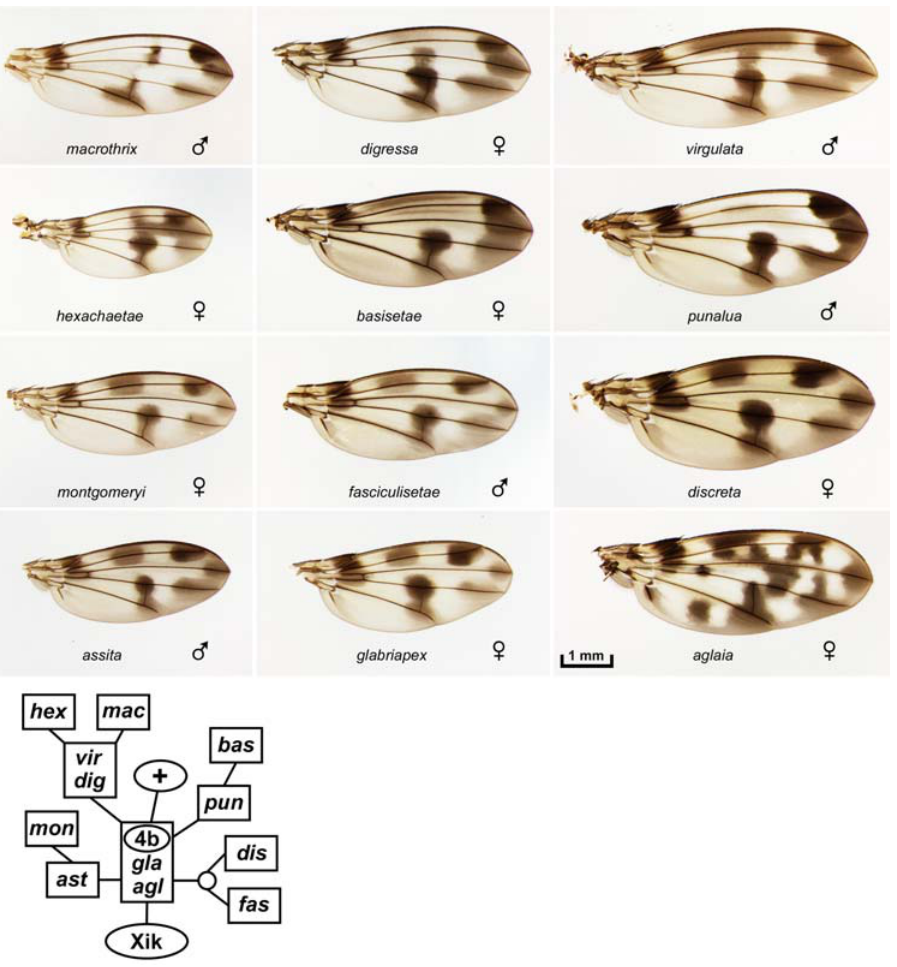
Figure 4. The glabriapex/4b subgroup of picture wing species: D. aglaia, assita, basisetae, digressa, fasciculisetae, glabriapex, hexachaetae, macrothrix, montgomeryi, punalua , and virgulata . Lower, chromosome inversion-based lineage for the species shown (see text).